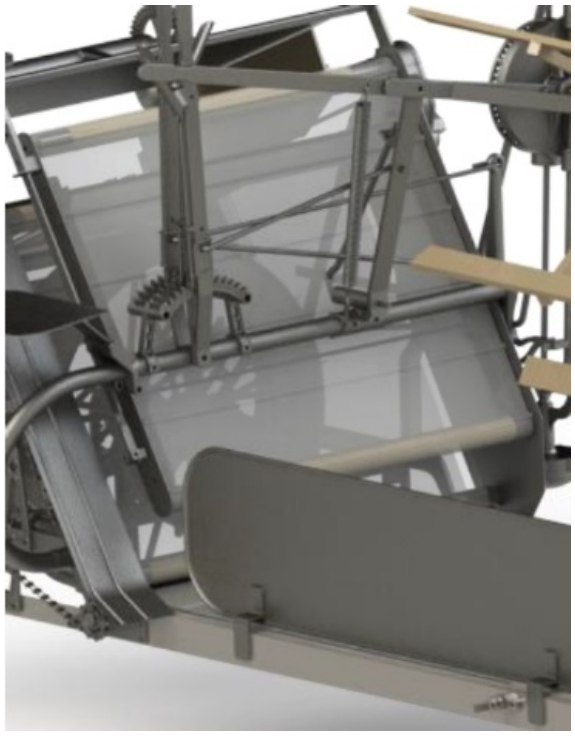
Figure 10. Top view of the rise conveyor system of the sheaves.